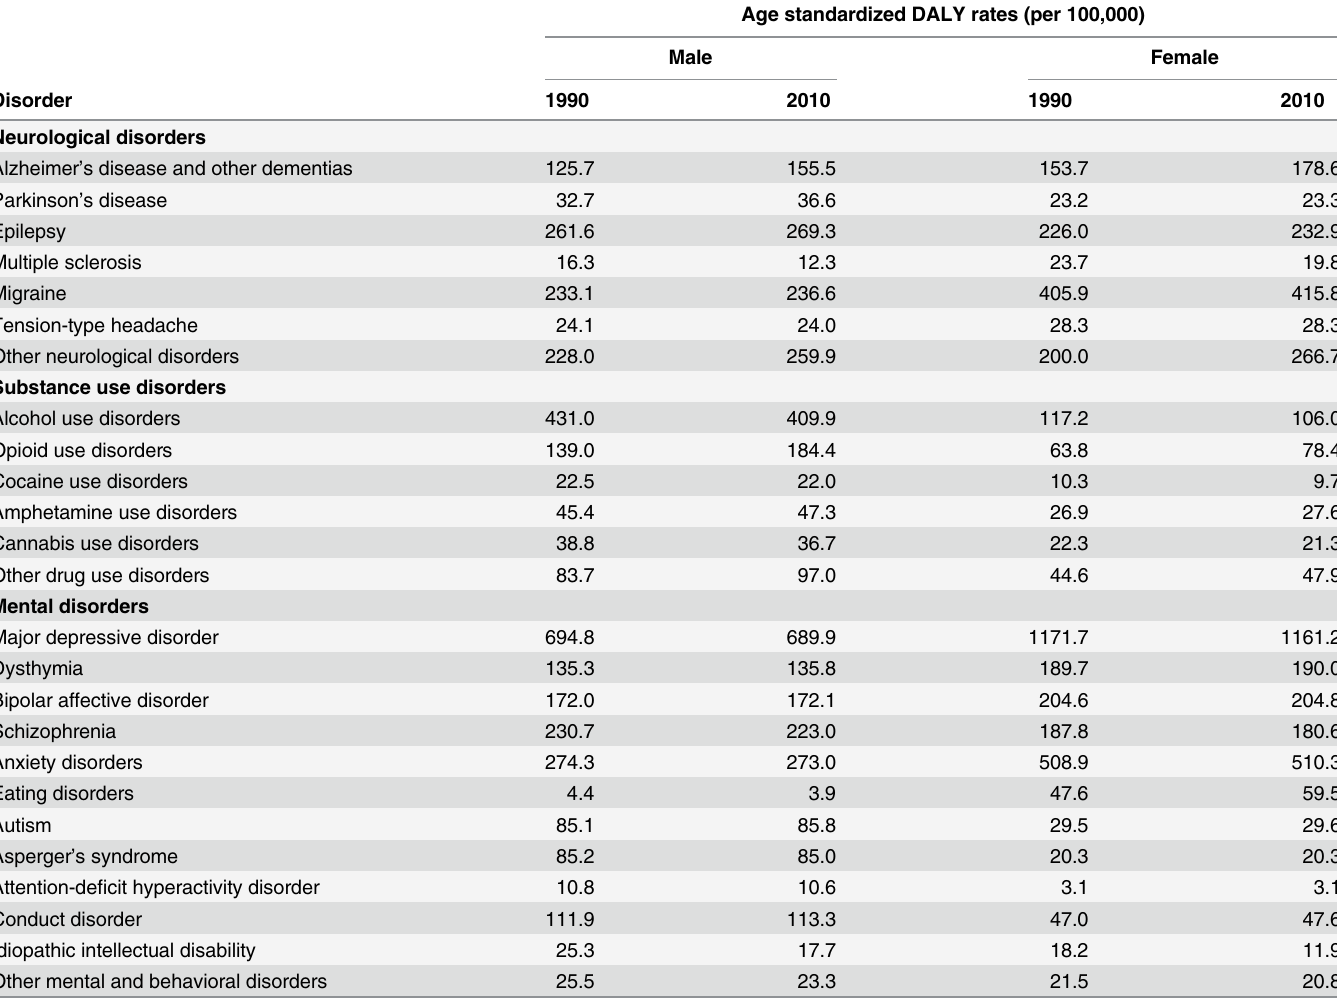
Table 2. Age-Standardized DALY Rates Attributable to Mental, Neurological, and Substance Use Disorders, 1990 and